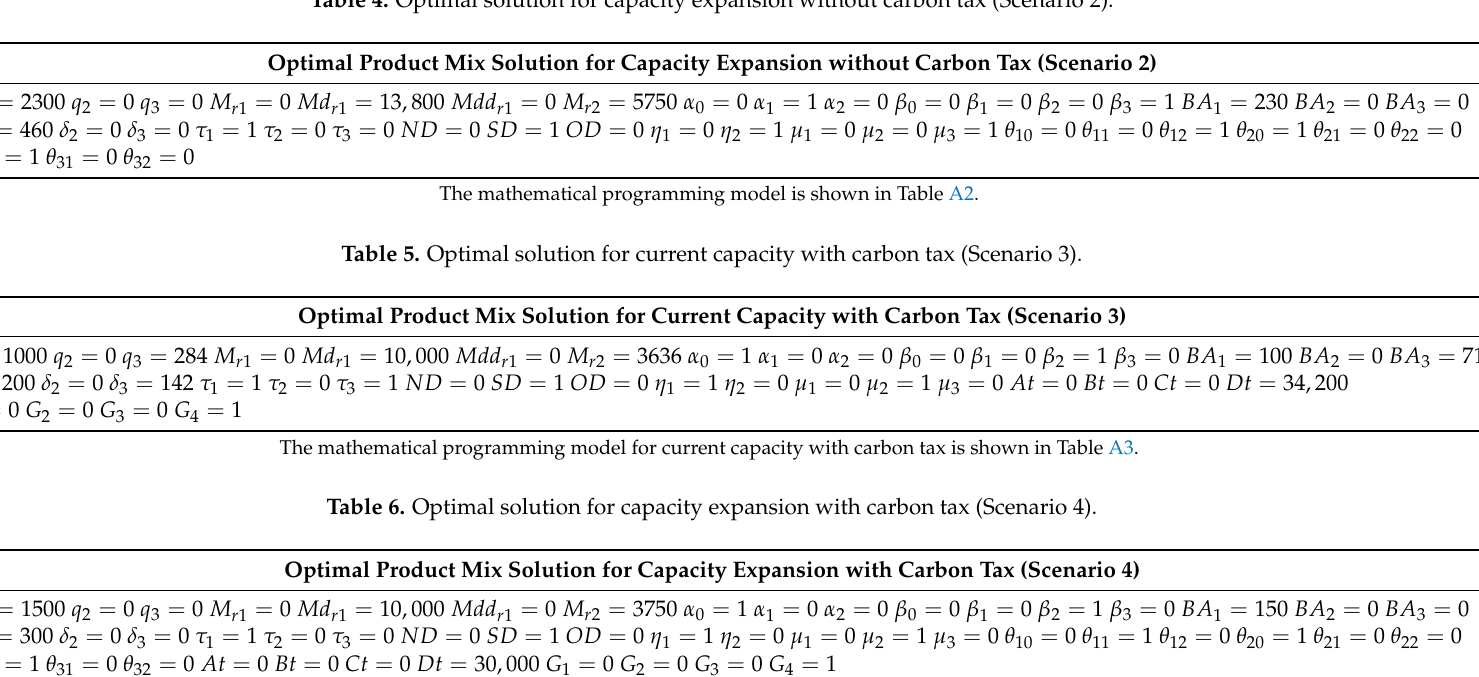
Table 4. Optimal solution for capacity expansion without carbon tax (Scenario 2).